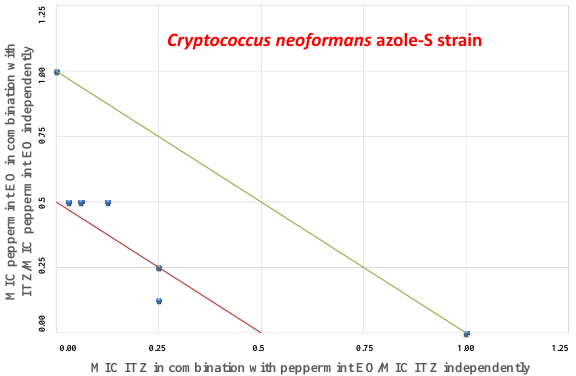
Figure 2. Isobologram of synergistic interactions: plot of “Mentha of Pancalieri” EO and ITZ against the Cryptococcus neoformans azole-S strain. ITZ FIC data are drafted on the x-axis, while EO FIC values are drafted on the y-axis.